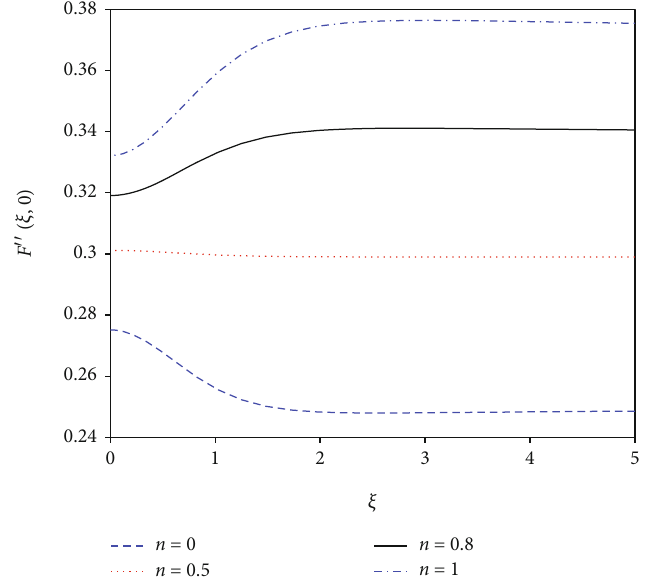
Figure 15: Development of the wall shear stress F ′′ ð ξ , 0 Þ for di ff erent values of constant parameter n , when K = 0 : 5, ξ = 5, Pr = 10, and S = N = Ω = He = 0 : R